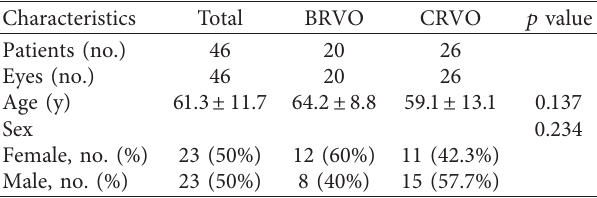
Table 1: Demographic characteristics of patients with RVO.